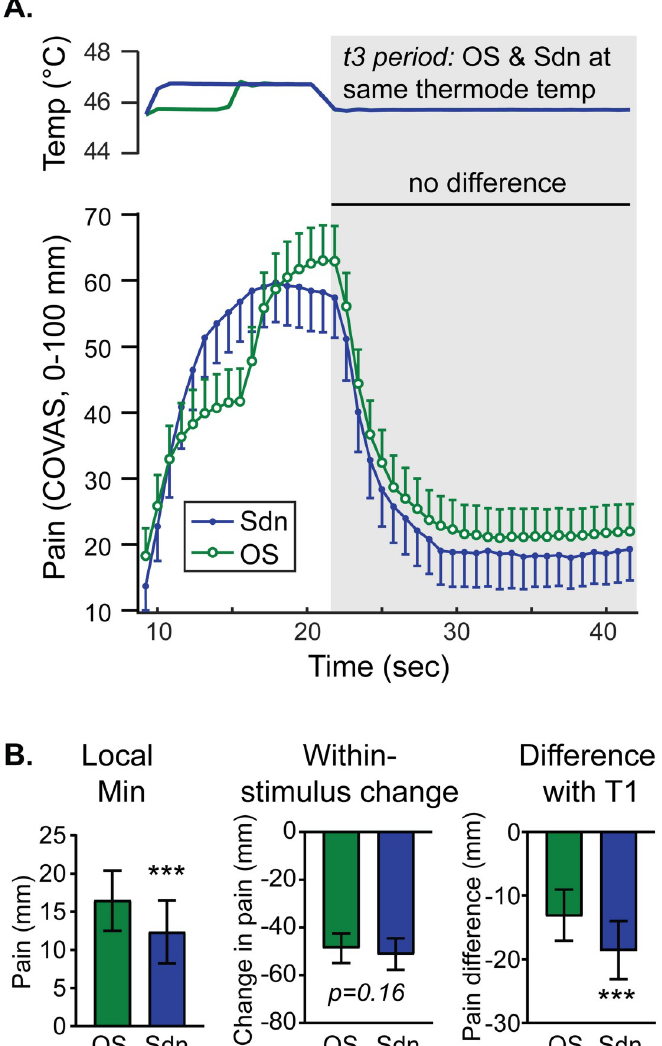
Fig 7. A noxious temperature decrease without a prior increase produces a subtly larger decrease in pain intensity. A. Group mean temperature (top) and continuous pain intensity rating (bottom) curves from the Sdn (blue circles) and OS (green circles) stimuli are shown. Symbols represent group-level mean and error bars represent 95% confidence intervals. Although a 2-way RM ANOVA with matching by stimulus and time showed main effects of time and stimulus, there was no statistically significant difference at any timepoint during the t3 interval. B. Group means obtained by within-subject analysis of minima (local min), the change in pain from maxima to minima (within- stimulus change) and the difference between stepped curve minima and T1 at equivalent timepoints (difference with T1) are plotted with error bars representing 95% CI. P-values: ��� p <